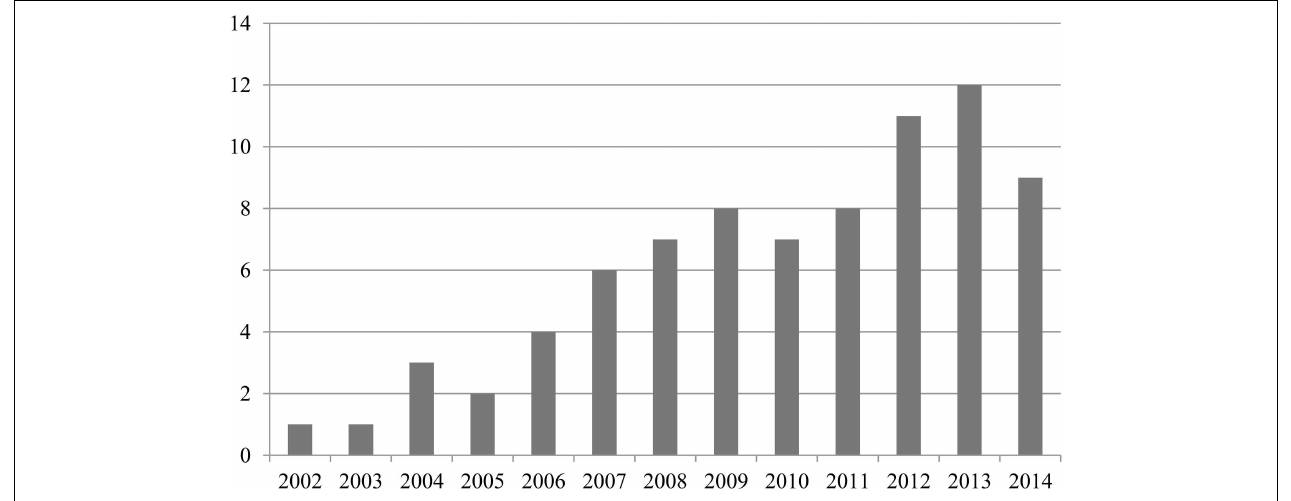
FIGURE 1 | Summary of publication years in the